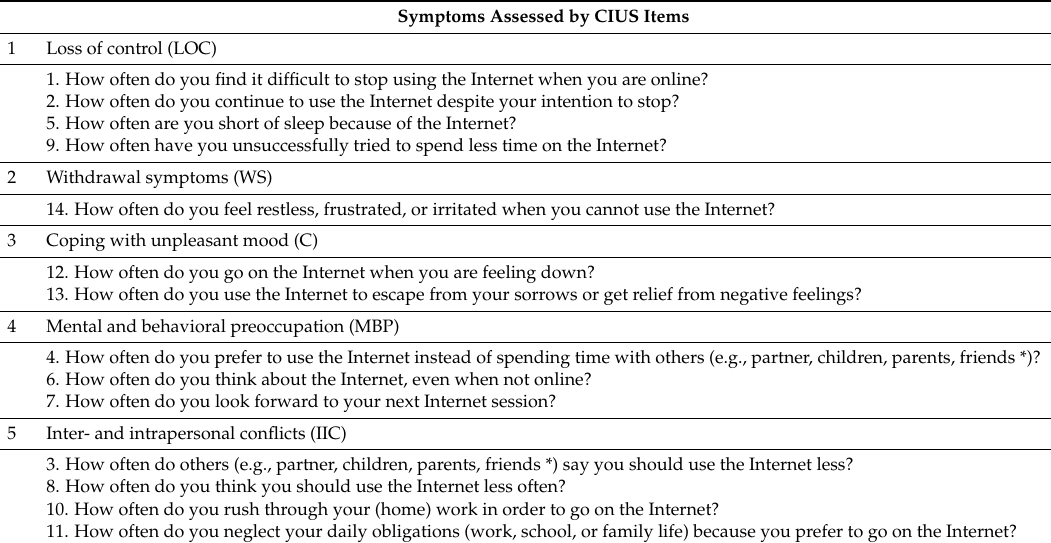
Table 1. Symptoms assessed by CIUS